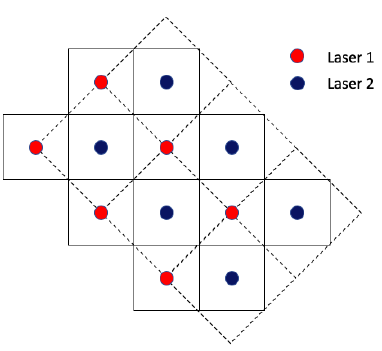
Figure 3. Dashed 18 × 18 pixel grid compared to the solid 12.7 × 12.7 pixel grid following a 45 degree mask rotation. The alternating laser subimages are centered within 13 × 13 pixel regions after the telescope magnification is